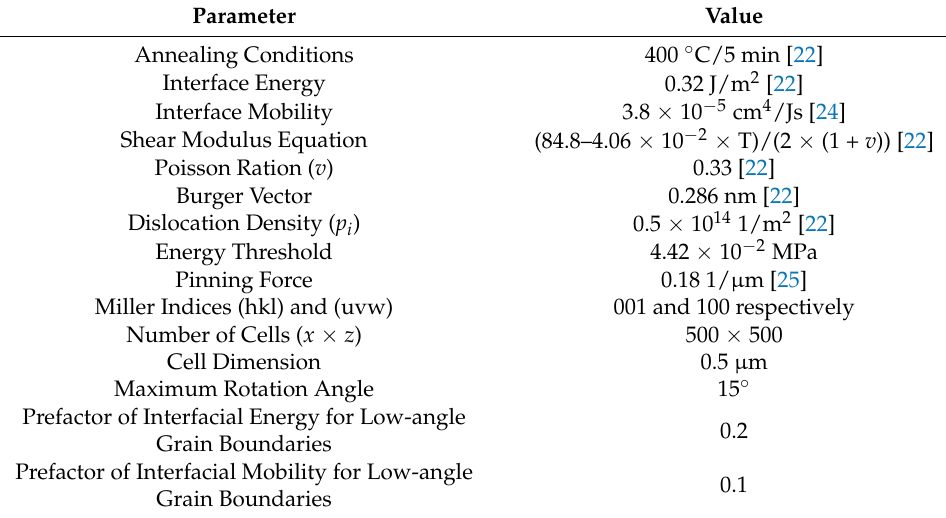
Table 2. Principal parameters of annealing